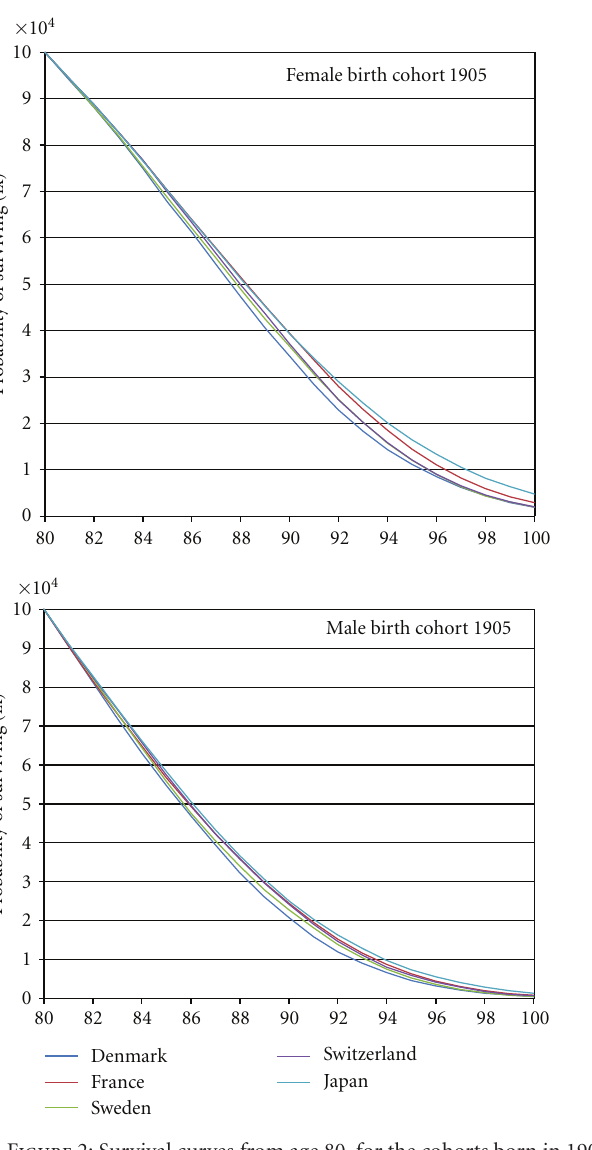
Figure 2: Survival curves from age 80, for the cohorts born in 1905 and 1910: Denmark, France, Japan, Sweden, and Switzerland. Table 2: Chance to survive from 80 to 95 and 100 for cohorts born in 1905 and 1910: Denmark, France, Japan, Sweden, and Switzerland. Denmark ( =